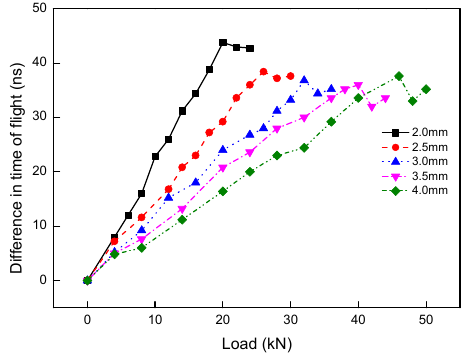
ff erence in time of flight and tensile Figure 7. The relation of difference in time of flight and tensile load. Figure 7. The relation of di Figure 7. The relation of difference in time of flight and tensile load.